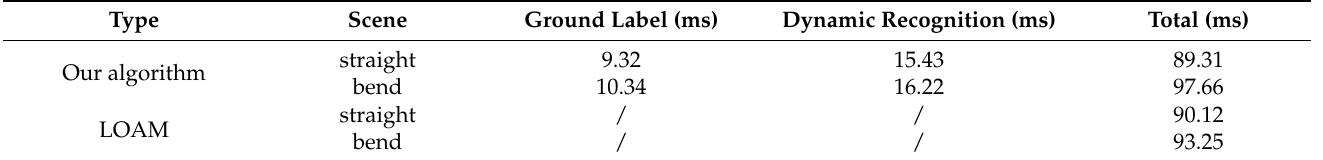
Table 3. Running